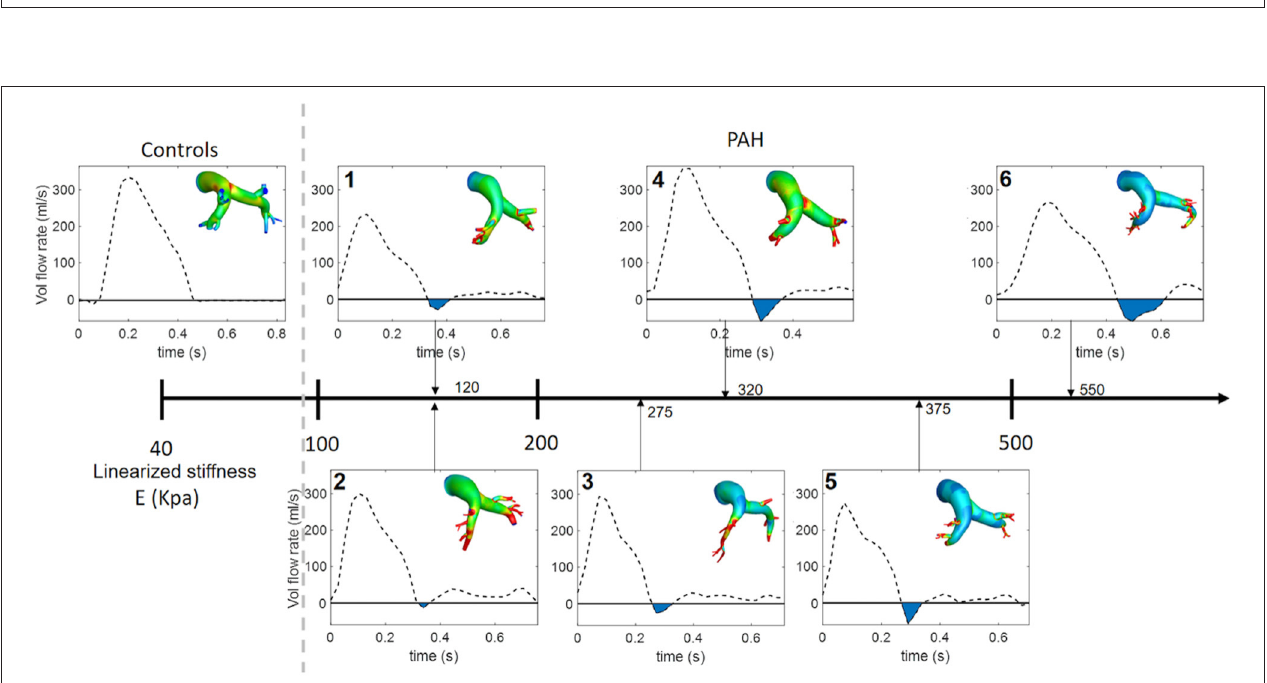
FIGURE 3 | Spatial distribution of the maximum surface displacement in all PAH and control patients organized from the case with the lowest (left) to the highest (right) elastic modulus.